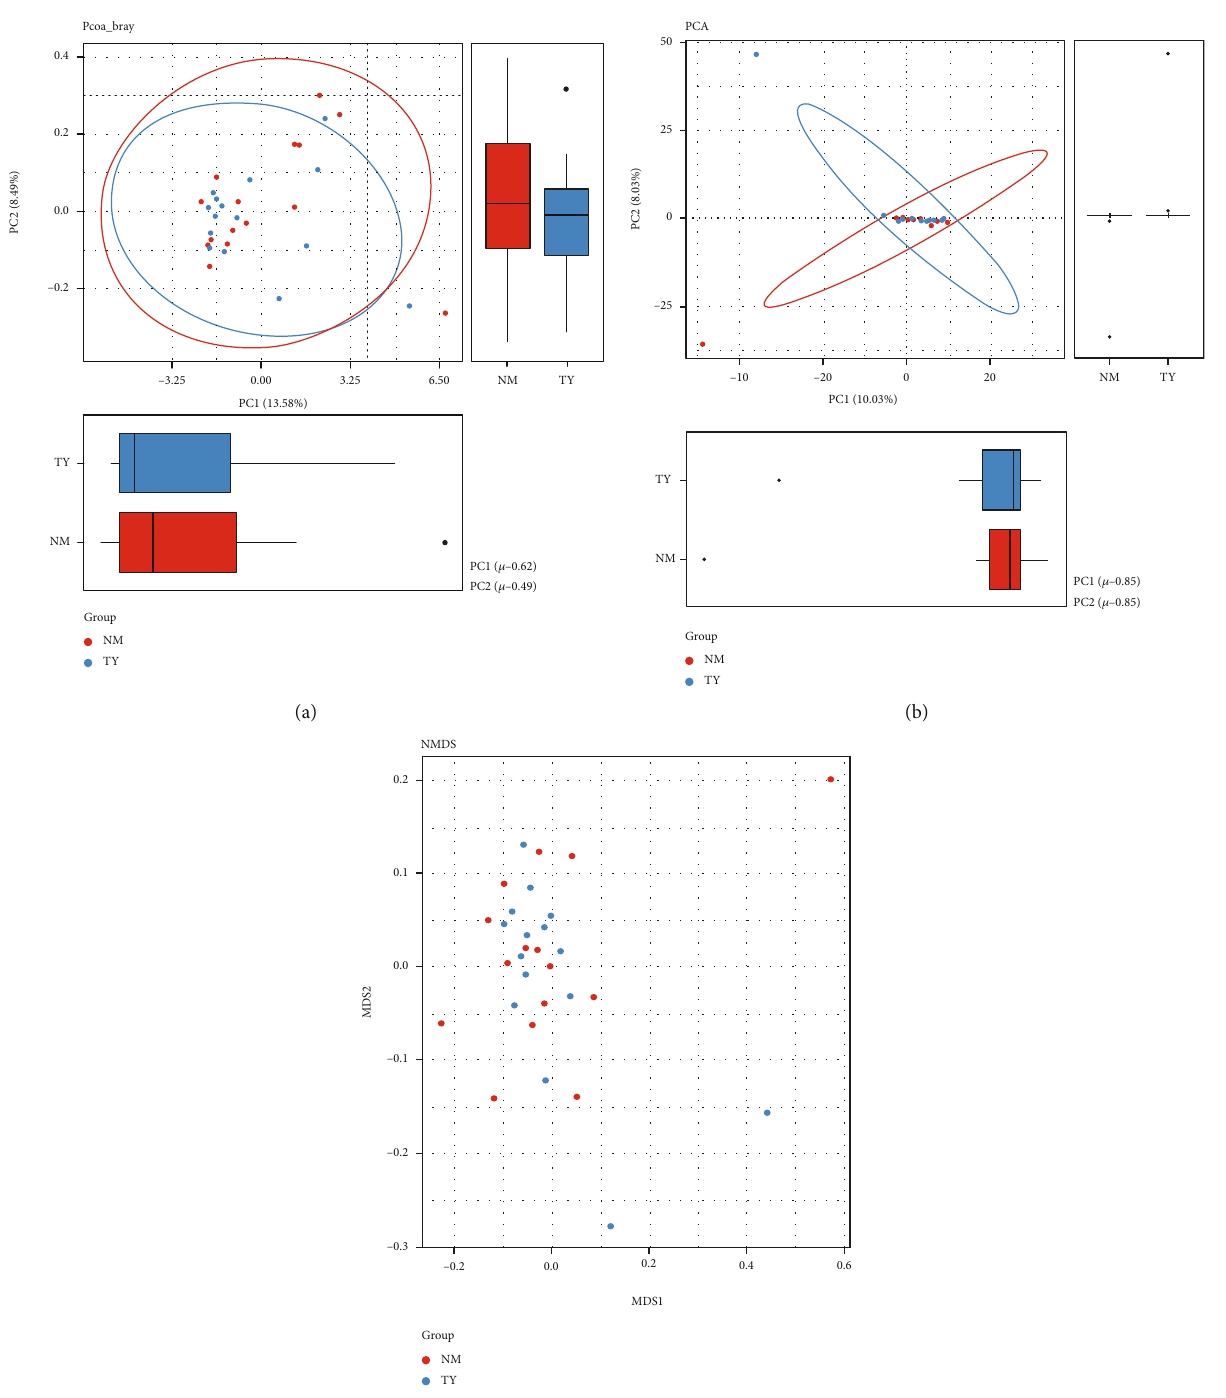
Figure 5: Beta-diversity comparison of microbiota in embryonic death group and control group. (a) PCoA, (b) PCA, and (c)